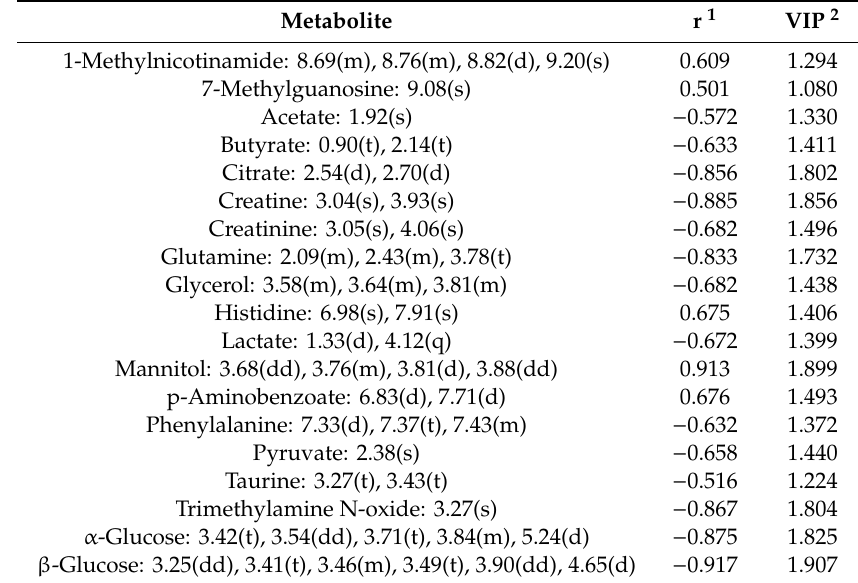
Table 1. OPLS-DA coe ffi cients and VIP values derived from the NMR data of A549 cells obtained from groups C and